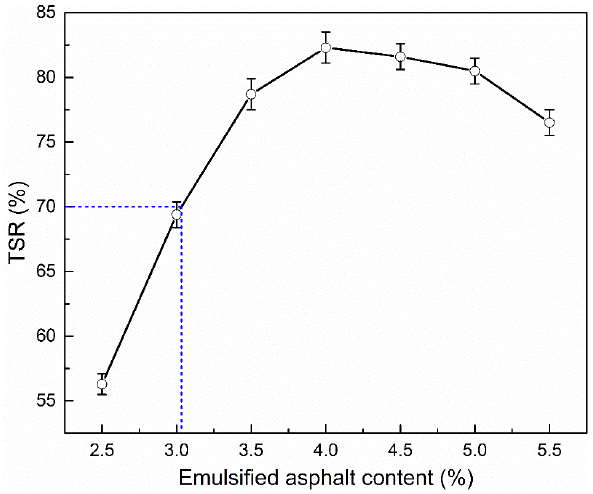
Figure 9. Influence of emulsified asphalt content on TSR. Table 7. Technical requirements for CRAM design